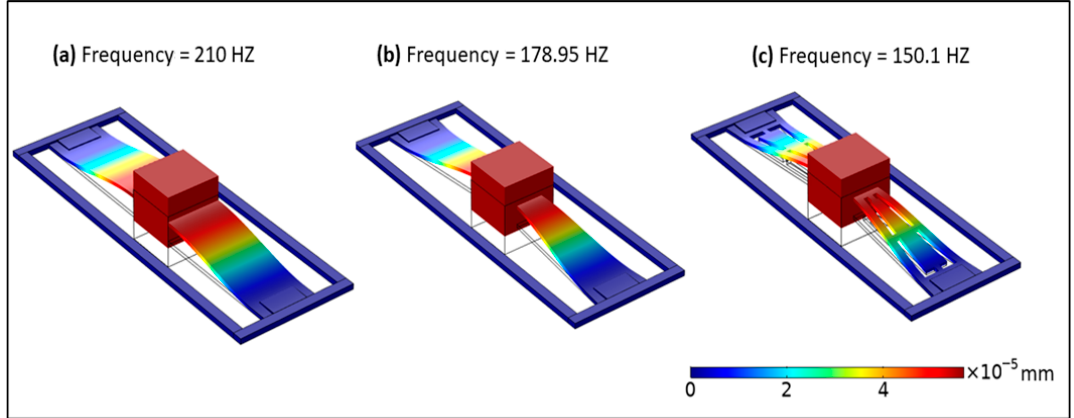
Figure 3. The resonant frequency of the nonlinear PEHs: ( a ) rectangular, ( b ) tapered, and ( c ) exsect-tapered.